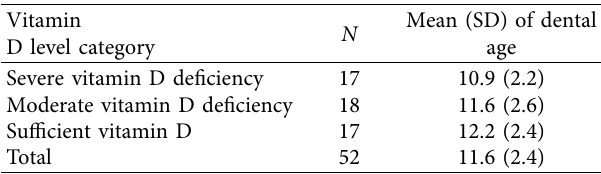
Abbreviations used in this table: SD � standard